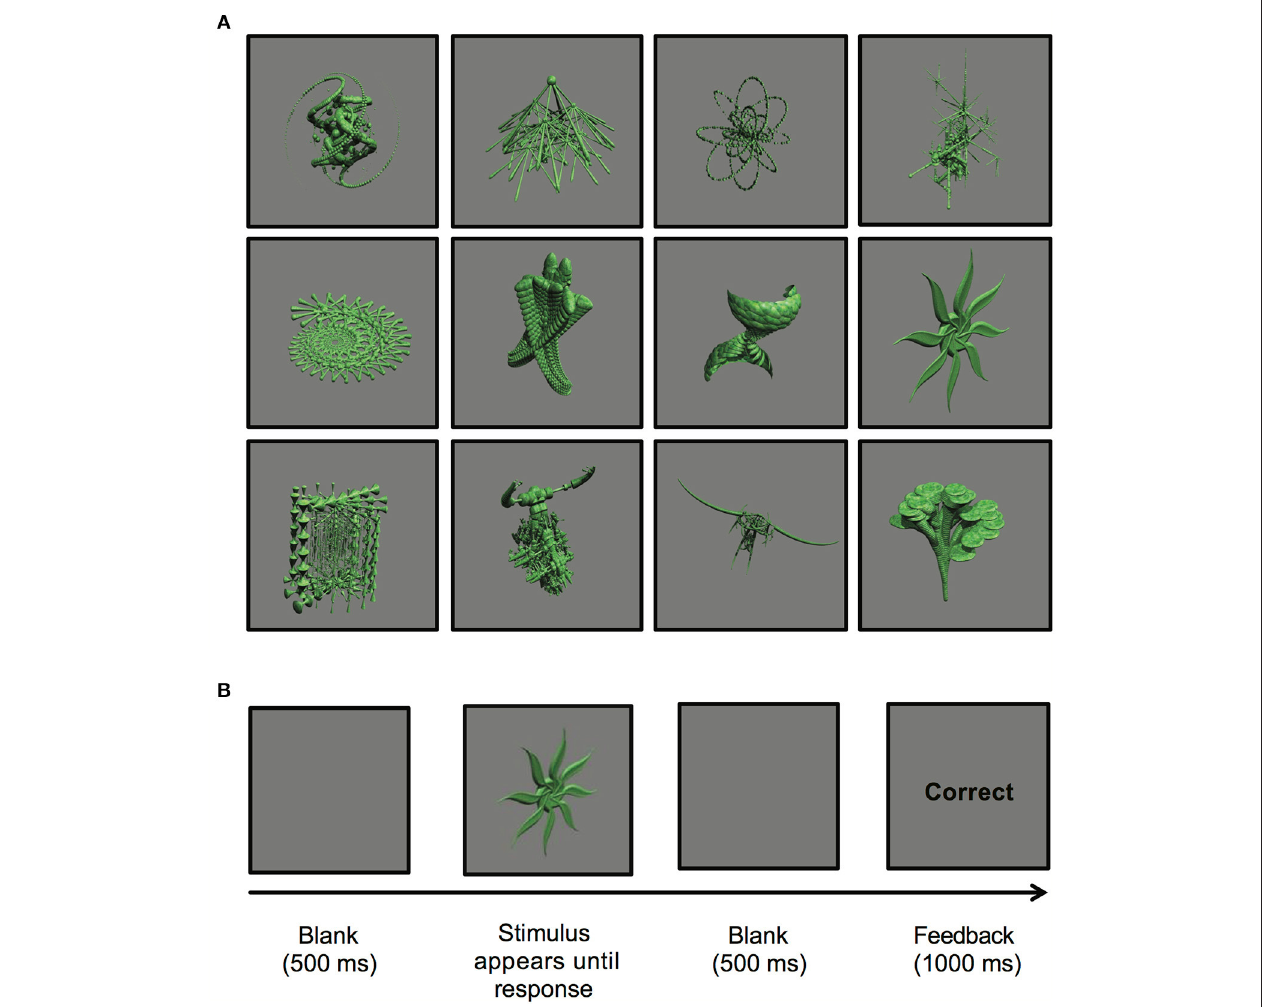
FIGURE 1 | (A) Computer-generated abstract images presented during the stimulus-response learning task ( GroBoto , Braid Art Labs, Colorado Springs, USA). (B) An example of a single stimulus-response learning trial.